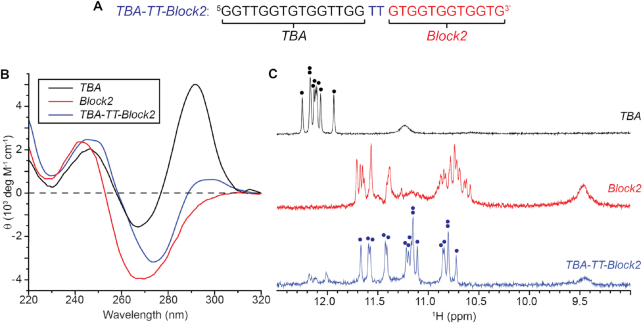
(A) Sequence, (B) CD and (C) NMR spectra of TBA (black), Block2 (red) and TBA-TT-Block2 (blue). The CD spectra of TBA and Block2 resemble that of right-handed anti-parallel G4 and left-handed parallel G4 respectively, while a unique spectrum is observed for TBA-TT-Block2.